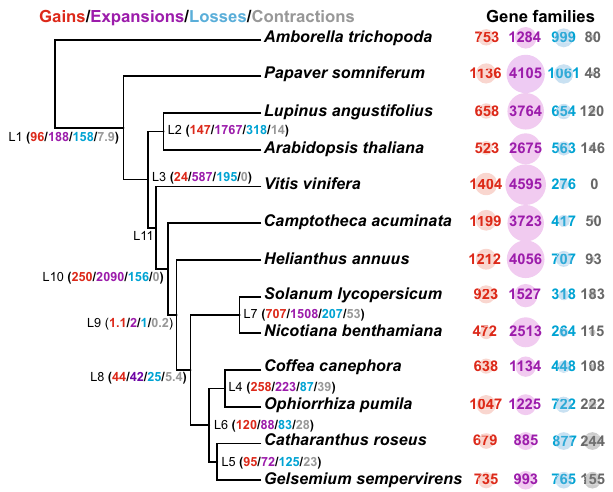
Fig. 5 Evolution as gain (red), expansion (purple), loss (blue), or contraction (gray) of the orthogene families in context of phylogenetic pro fi le. Count software was used to calculate posterior probabilities to capture the dynamics of evolution through the reconstruction of ancestral gene content and changes at the key nodes, which correspond to the lineage-speci fi c gene characteristics. The circle radius is scaled based on the number of genes assigned to a speci fi c category. Source data are provided as a Source data fi